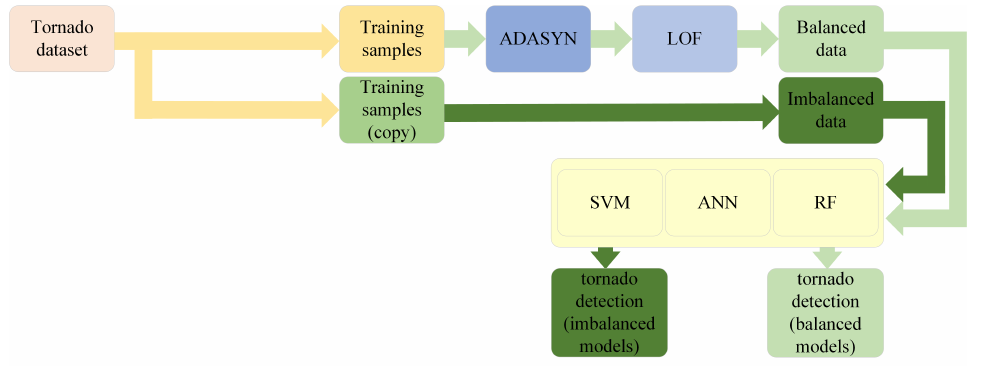
Figure 5. The flow chart of experiment